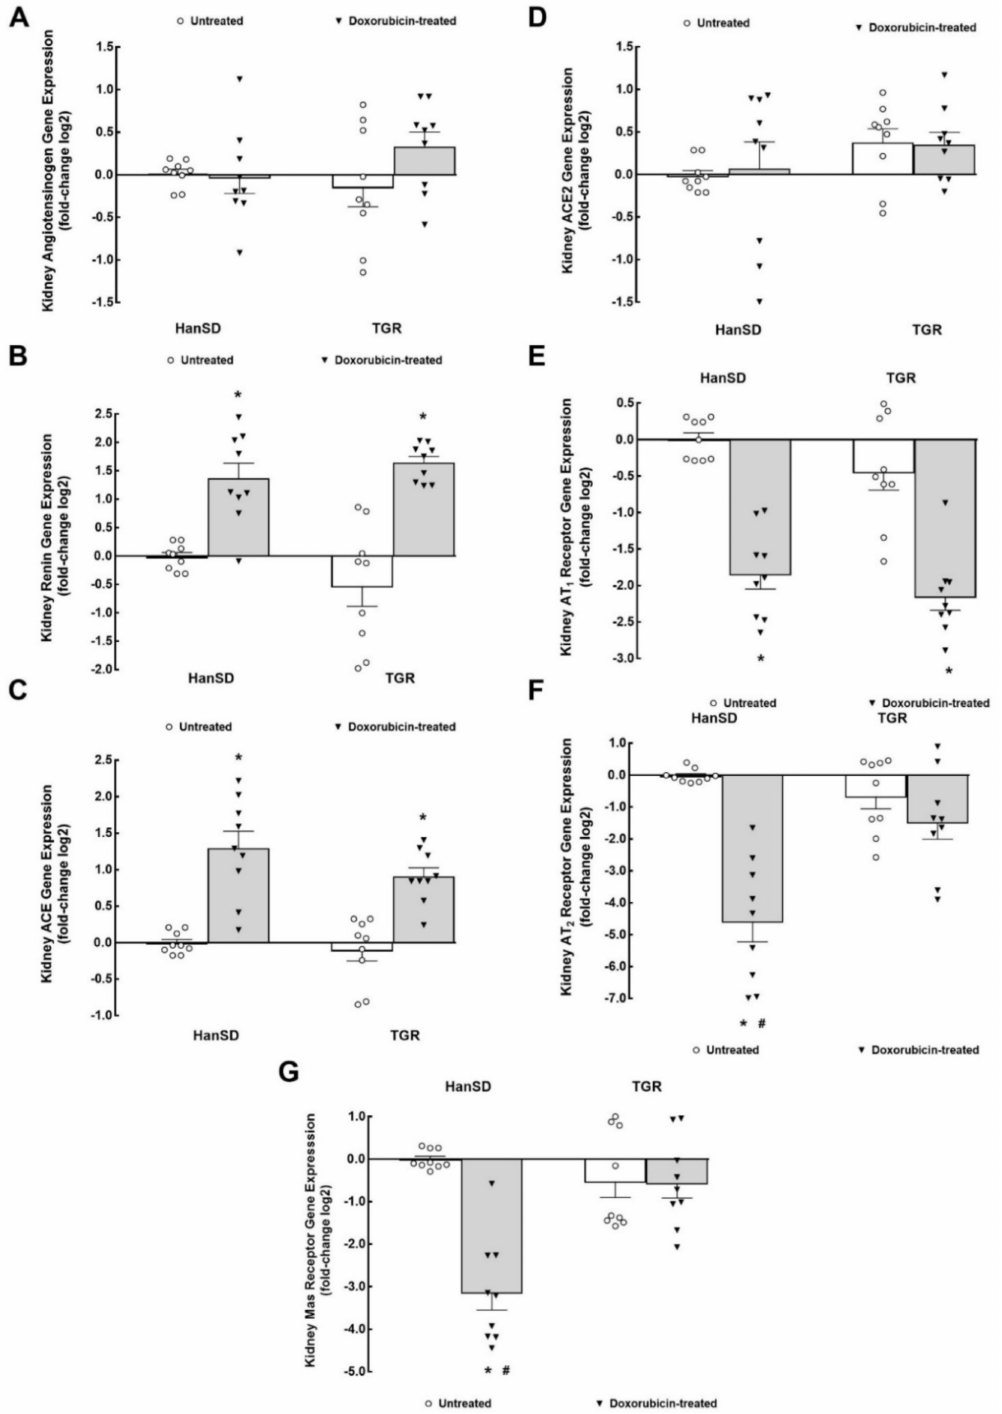
Figure 4. The first part of kidney mRNA expression. Kidney angiotensinogen ( A ), renin ( B ), angiotensin-converting enzyme ( ACE ) ( C ), angiotensin-converting enzyme type 2 ( ACE2 ) ( D ), angiotensin II type 1 ( AT 1 ) receptor ( E ), angiotensin II type 2 ( AT 2 ) receptor ( F ) and Mas receptor ( G ) gene expression in untreated and doxorubicin-treated normotensive, transgene-negative Hannover Sprague–Dawley (HanSD) and hypertensive, Ren-2 transgenic (TGR) rats. * p < 0.05 compared with untreated animals of the same strain. # p < 0.05 versus TGR within the same protocol. The values are means ± SEM. Statistical comparison was made by one-way ANOVA